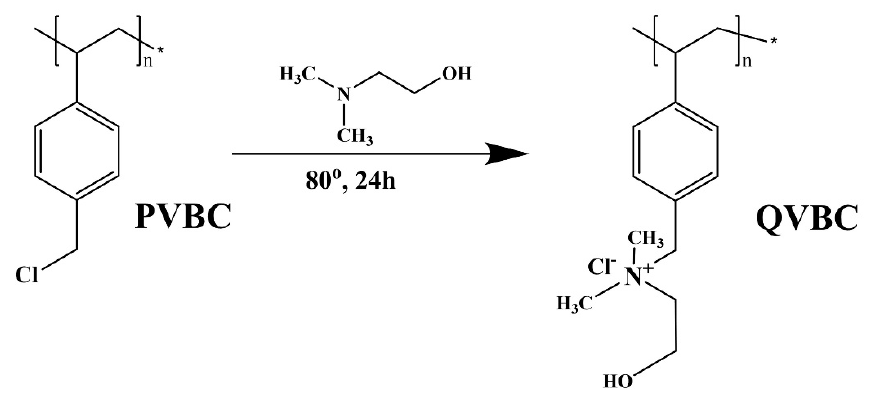
Figure 3. Synthesis of positively quaternized vinyl benzyl chloride (QVBC).